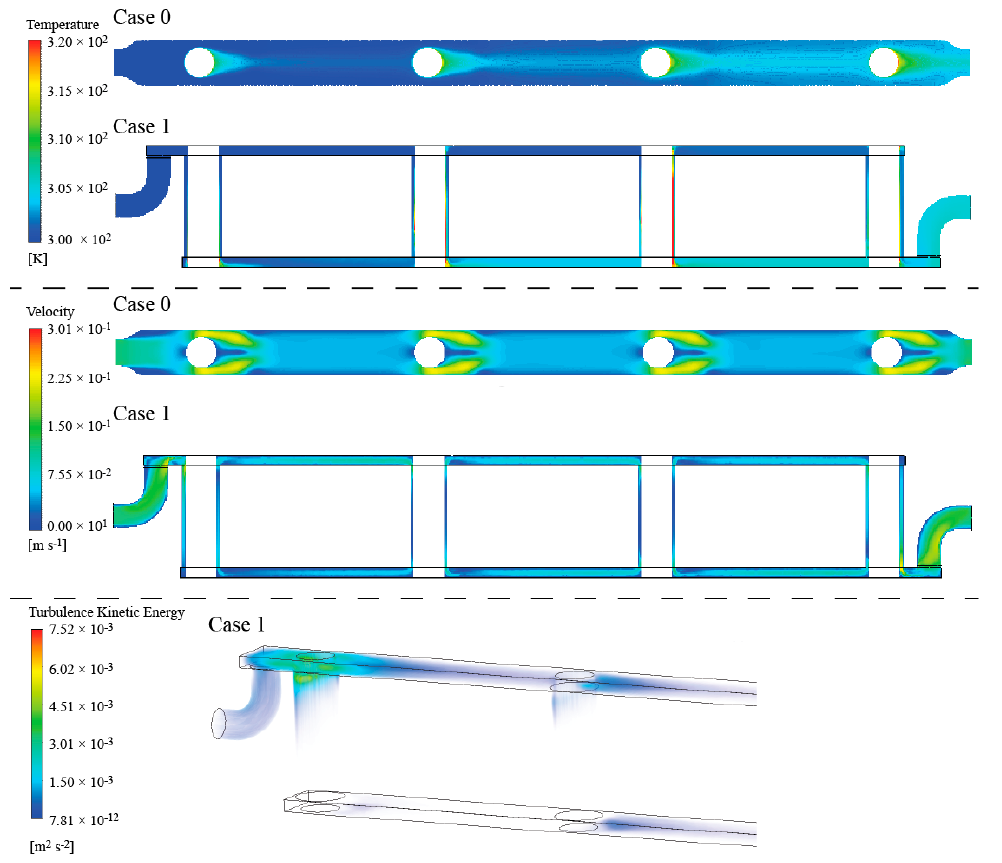
Figure 6. Results of CFD analysis of the basic concept of the proposed manifold header ( top — temperature contour map, middle —flow velocity contour map, bottom —3D visualization of turbulence kinetic energy).